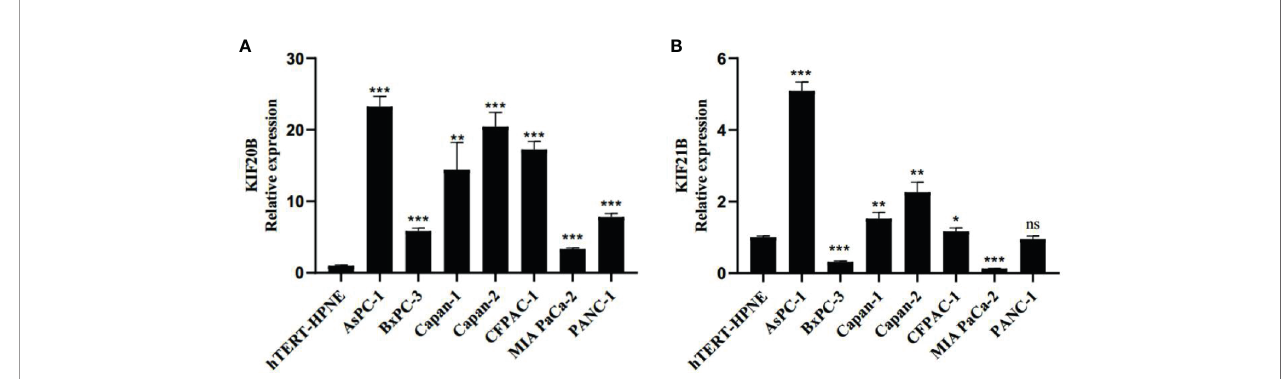
FIGURE 13 | Real-time quantitative PCR (RT-qPCR) evaluate the expression pattern of KIF20B and KIF21B in pancreatic cancer cell lines and normal pancreatic cell. (A) The expression pattern of KIF20B in pancreatic cancer cell lines and normal pancreatic cell. (B) The expression pattern of KIF21B in pancreatic cancer cell lines and normal pancreatic cell. ns, not signi fi cant. “ * ” denote p < 0.05; “ ** ” denote p < 0.01; “ *** ” denote p < 0.001; “ **** ” denote p